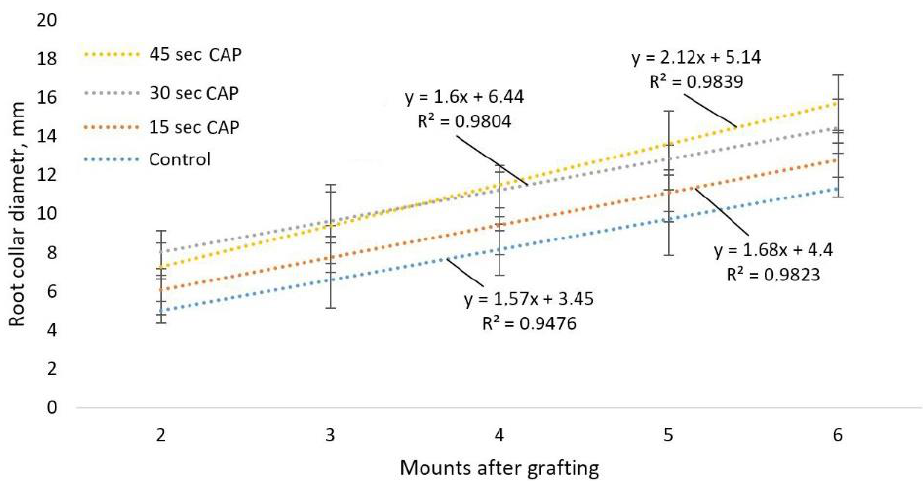
Figure 10. The results of measuring the diameters of the root necks of cherry seedlings of the “Revna” variety within 4 months after planting in the greenhouse with direct treatment and different durations of exposure to CAP (15 s, 30 s and 45 s).